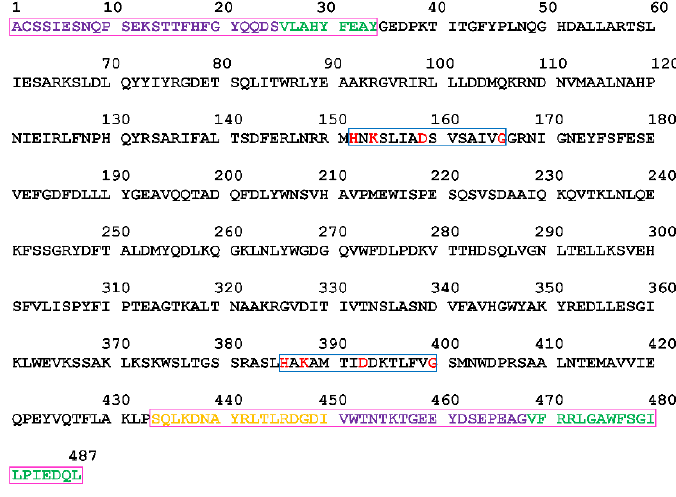
Figure 1. Full-length amino acid sequence of the mature Phospholipase D (PLD) from Vibrio parahaemolyticus (VpPLD). The two conserved HKD motifs are labeled by blue frames, and key residues within them are labeled in red. The N- and C-terminal peptides investigated in the present study are labeled by purple frames. Various amino acid sequences within these peptides are labeled with different colors.